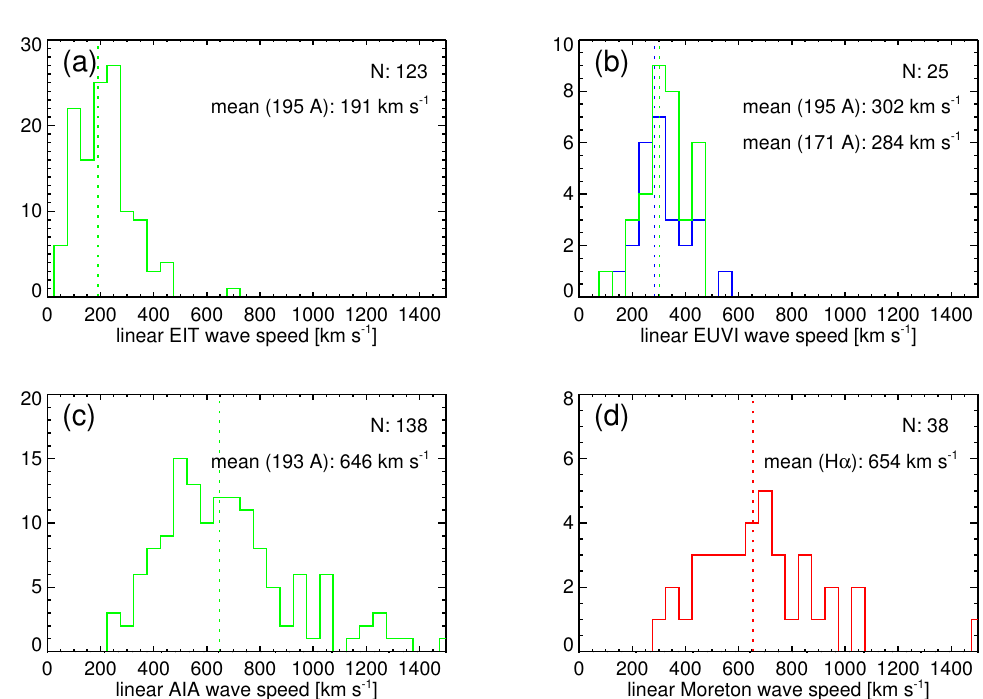
Figure 22: Histograms of the linear speeds of coronal waves obtained from different instruments and wavelengths. The mean of the distributions is given and plotted as a dotted line, and 𝑁 denotes the number of events. (a): EIT wave speeds from Thompson and Myers (2009). (b): EUVI wave speeds (measured from 195 ˚A and 171 ˚A images) from Nitta et al. (2014). (c): AIA wave speeds from Nitta et al. (2013). (d): Moreton wave speeds combined from Smith and Harvey (1971); Warmuth et al. (2004a); Zhang et al.